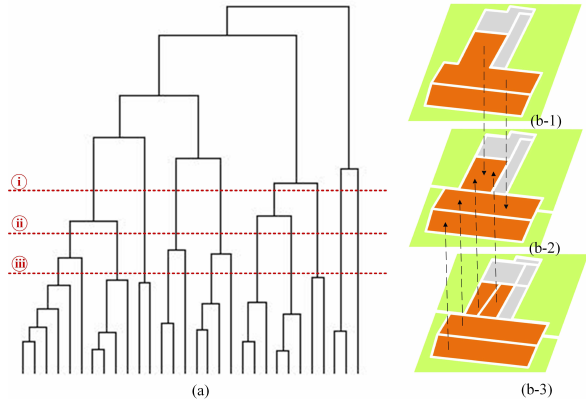
Figure 3. The hierarchical segmentation tree(a) and The corresponding segmentation images(b) for label